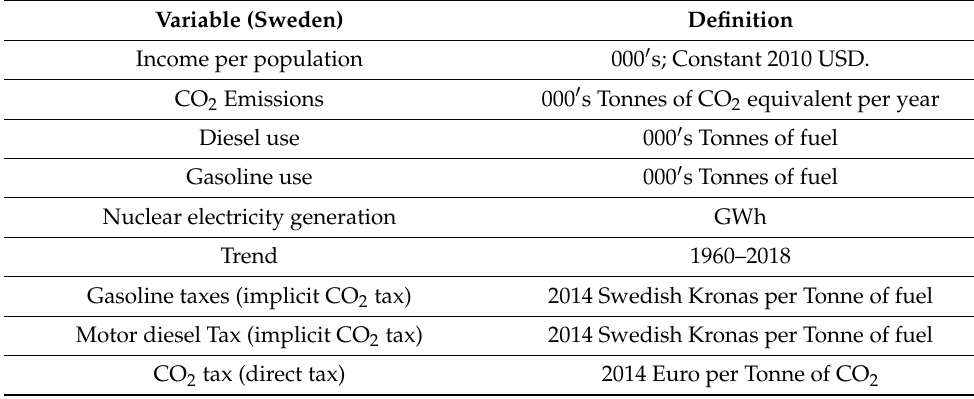
Table 3. Definition of variables for Sweden in sample.